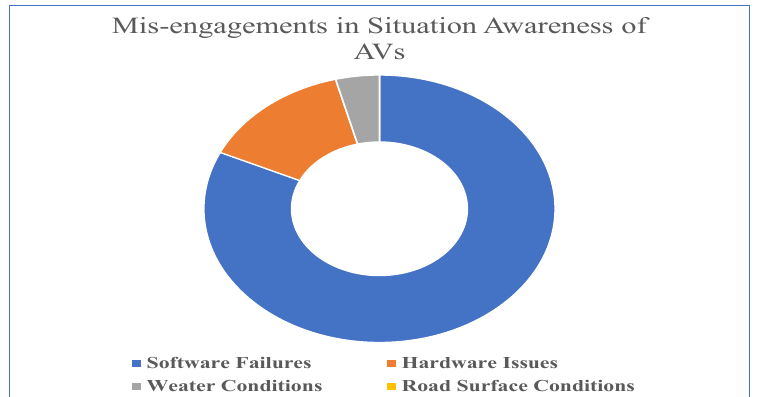
Figure 8. Percentage of failures due to misengagements in